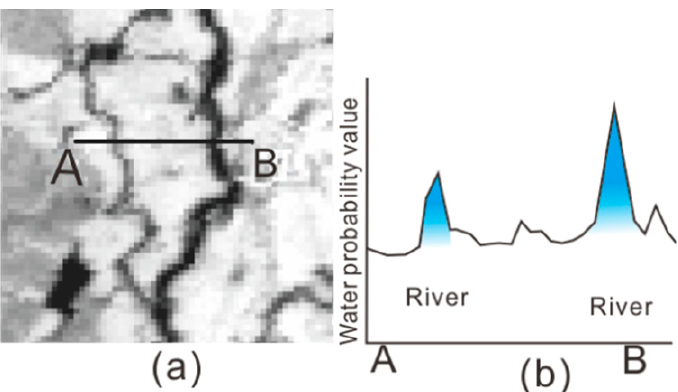
Figure 7. Probability map of the tributary water bodies: ( a ) water probability of tributaries; ( b ) probability curve of tributary water bodies.